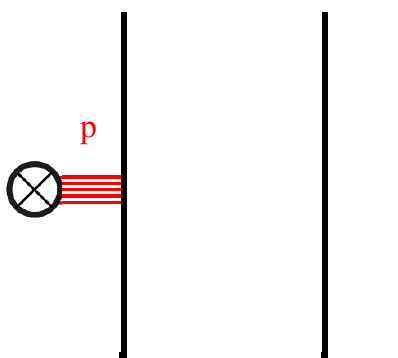
Figure 12 . This (cid:12)gure shows the brane con(cid:12)guration for a reducible SU(2) ’t Hooft defect with charge P = p h 1